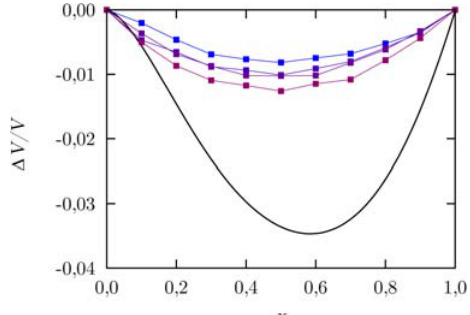
Figure 6: Excess volume as a function of mass fraction of methanol. Symbols represent simulation results at T* = 0.5 (blue), 0.6, 0.7 and 0.8 (red) and p* = 0.018 with connecting lines as guides-for-eye. So- lid continuous line represents experimental data at 20 °C and 1 atm.